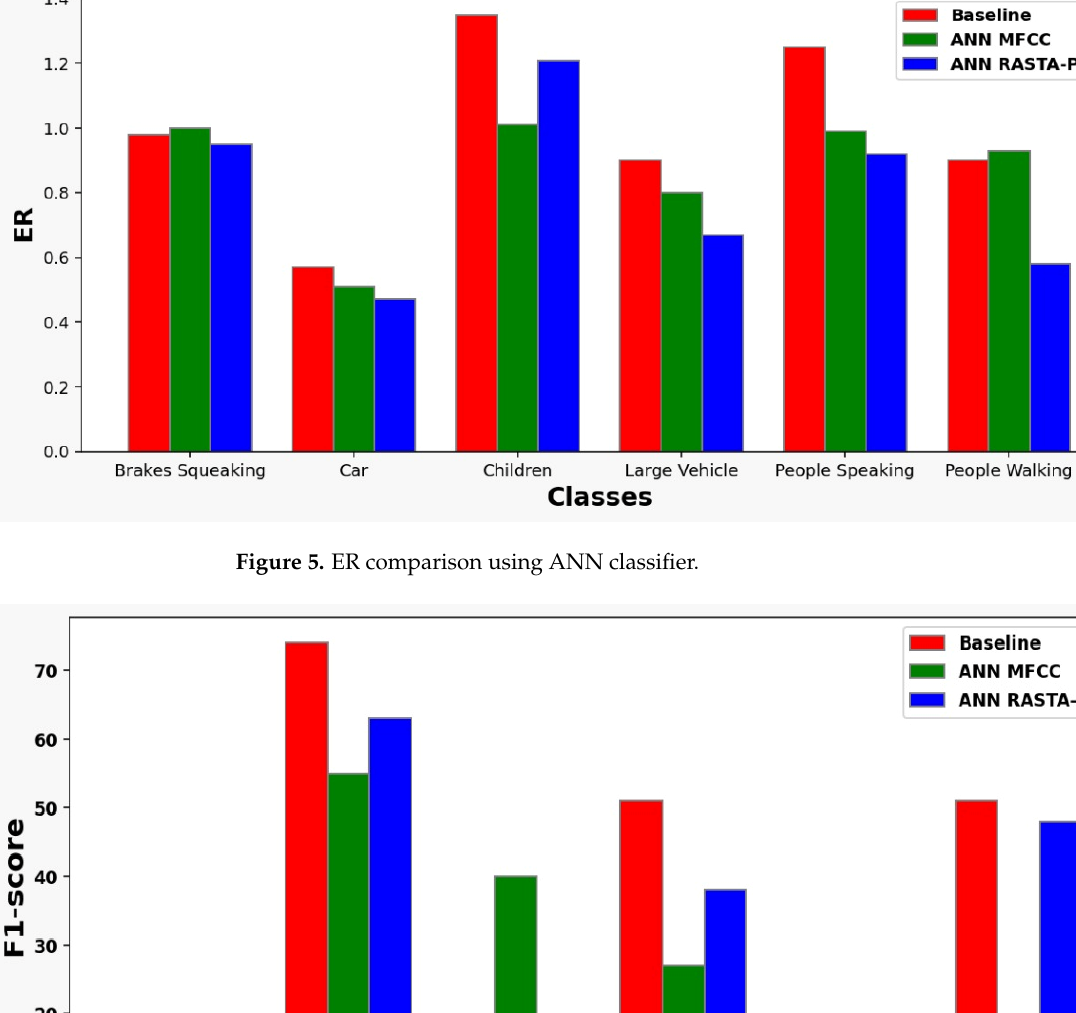
Figure 5. ER comparison using ANN classifier .